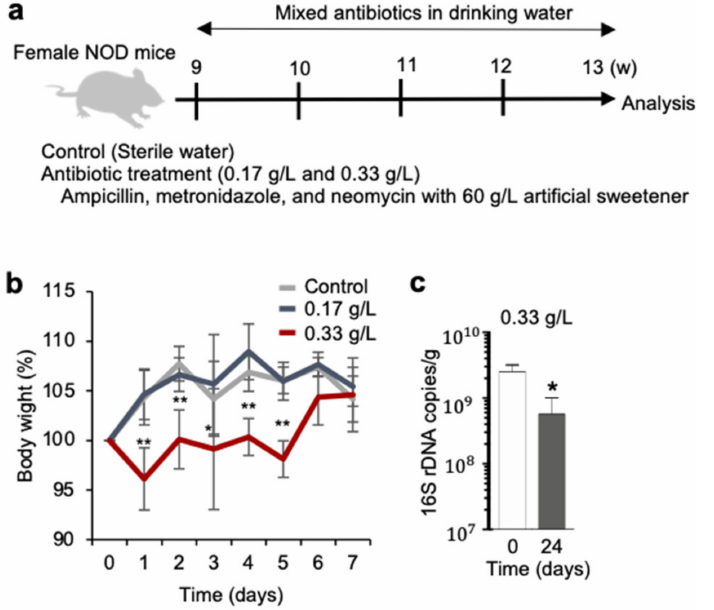
Figure 1. Administration of antibiotics to non-obese diabetic (NOD) mice. ( a ) Antibiotics (0.17 and 0.33 g/L) were mixed in drinking water along with an artificial sweetener (60 g/L) and were administered to NOD mice during 4 weeks from 9 to 13 weeks of age. ( b ) Body weight was monitored during antibiotic administration. Relative change in body weight was determined by comparing body weight at experiment start and end. All experiments were repeated four times. Data are presented as mean ± SD of 16 mice in control and 0.33 g/L groups, and for 9 mice in the 0.17 g/L group; * p < 0.05, ** p < 0.01. ( c ) Bacterial 16S rDNA was determined by quantitative PCR. Data are presented as mean ± SD of three mice in each group; * p <